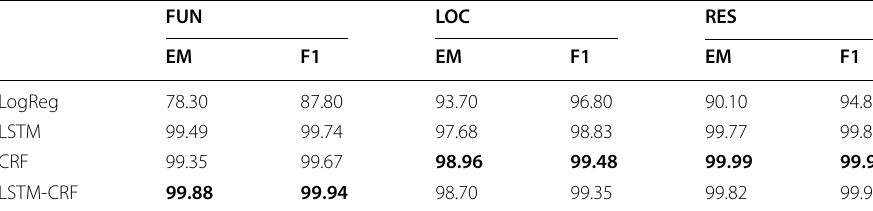
Bolded text is used to indicate the best performing values